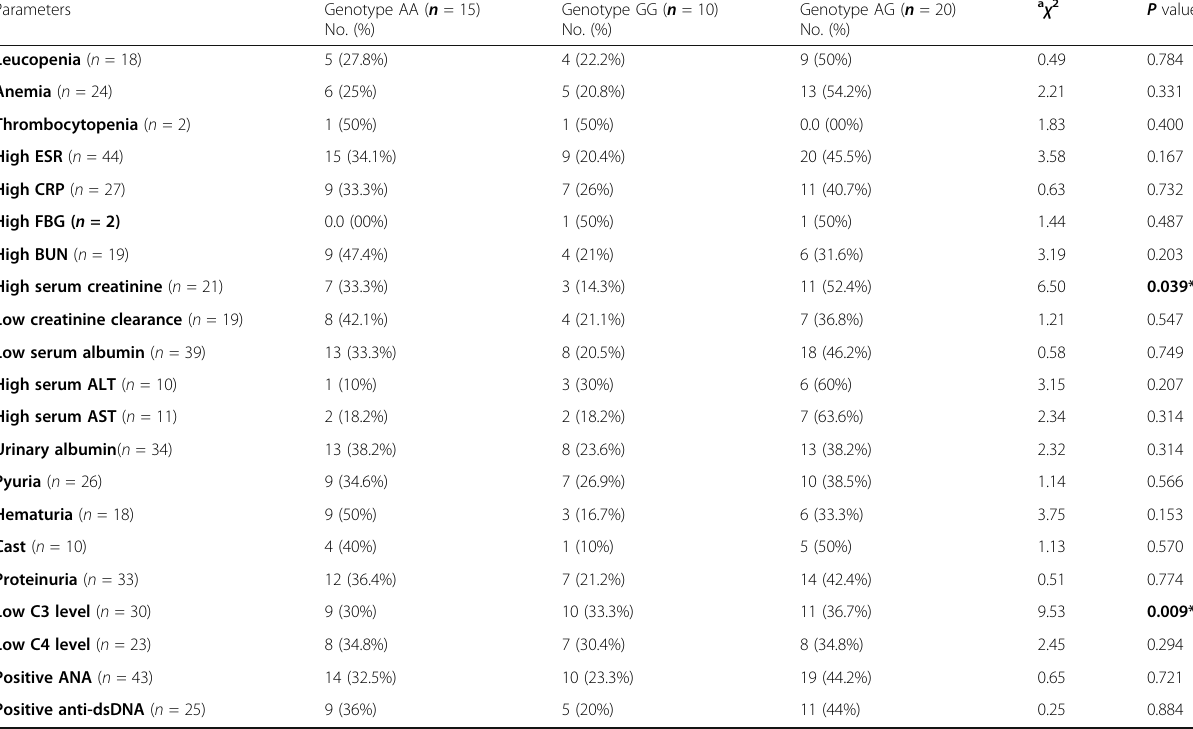
Table 3 XRCC1 Arg 399 Gln polymorphism with laboratory and immunological parameters among SLE patients ( n = 45) Parameters Genotype AA ( n = 15) Genotype GG ( n = 10) No. (%) No. (%)